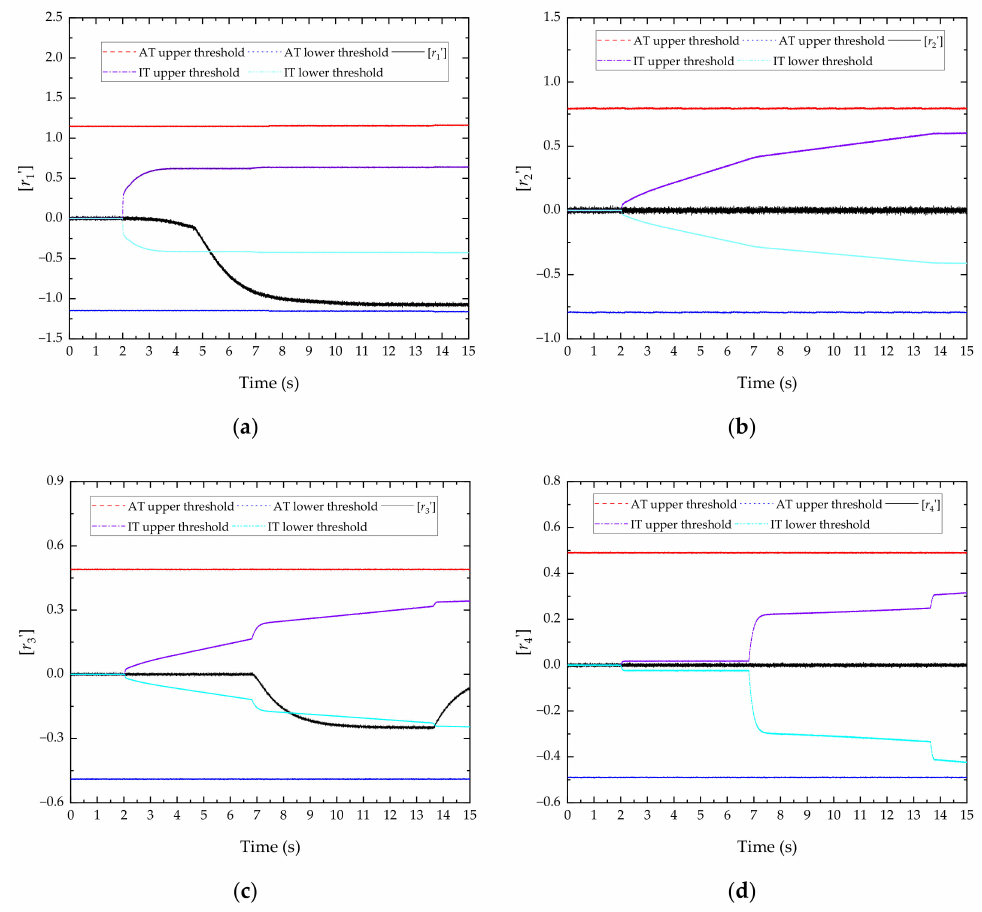
Figure 18. External and internal leakage of actuator fault detection results: ( a ) [ r 1 (cid:48) ] ( b ) [ r 2 (cid:48) ] ; ( c ) [ r 3 (cid:48) ] ; ( d ) [ r 4 (cid:48) ]